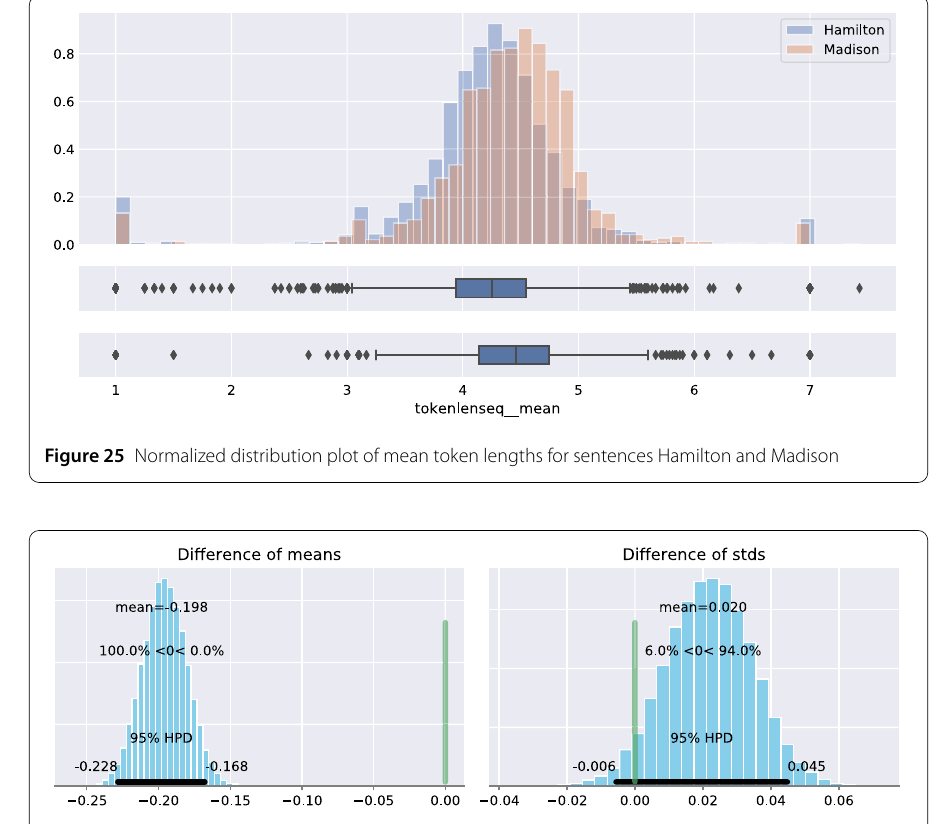
Figure 26 Posterior distributions and 95% credible intervals of differences for the “mean” feature. Left is the difference of group means, and right is the difference of group standard